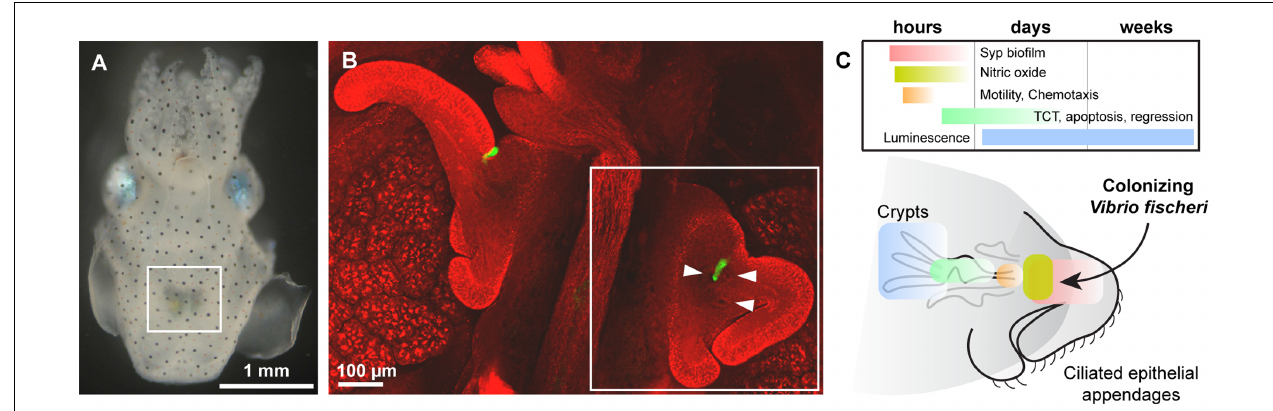
FIGURE 1 | (A) Juvenile Euprymna scolopes hatchling, ventral view. White box highlights the ink sac and the light organ. (B) Confocal micrograph of the bilaterally symmetric light organ. Host tissue is counterstained in red and the colonizing bacteria are visible in green. Arrowheads point to the three pores on one side of the organ, into which Vibrio fischeri swim into the internal anatomy (ducts, antechamber, bottleneck, and crypts) of the organ. White box highlights one half of the organ, which is shown in cartoon view in the next panel. (C) Current state of knowledge about the temporal and spatial action of key processes discussed in this review, including Syp biofilm formation and aggregation (red), host nitric oxide (NO) production (yellow), bacterial motility and chemotaxis toward host chitin oligosaccharides (orange), symbiont TCT release (green), and luminescence (blue). In general the location of the colonizing bacteria are highlighted; e.g., for TCT release the bacteria colonize the crypts and release TCT (indicated), though the effect of this release on the host is apoptosis and regression of the ciliated epithelial appendages (not indicated in this representation). (A,B) Are adapted from Mandel et al.